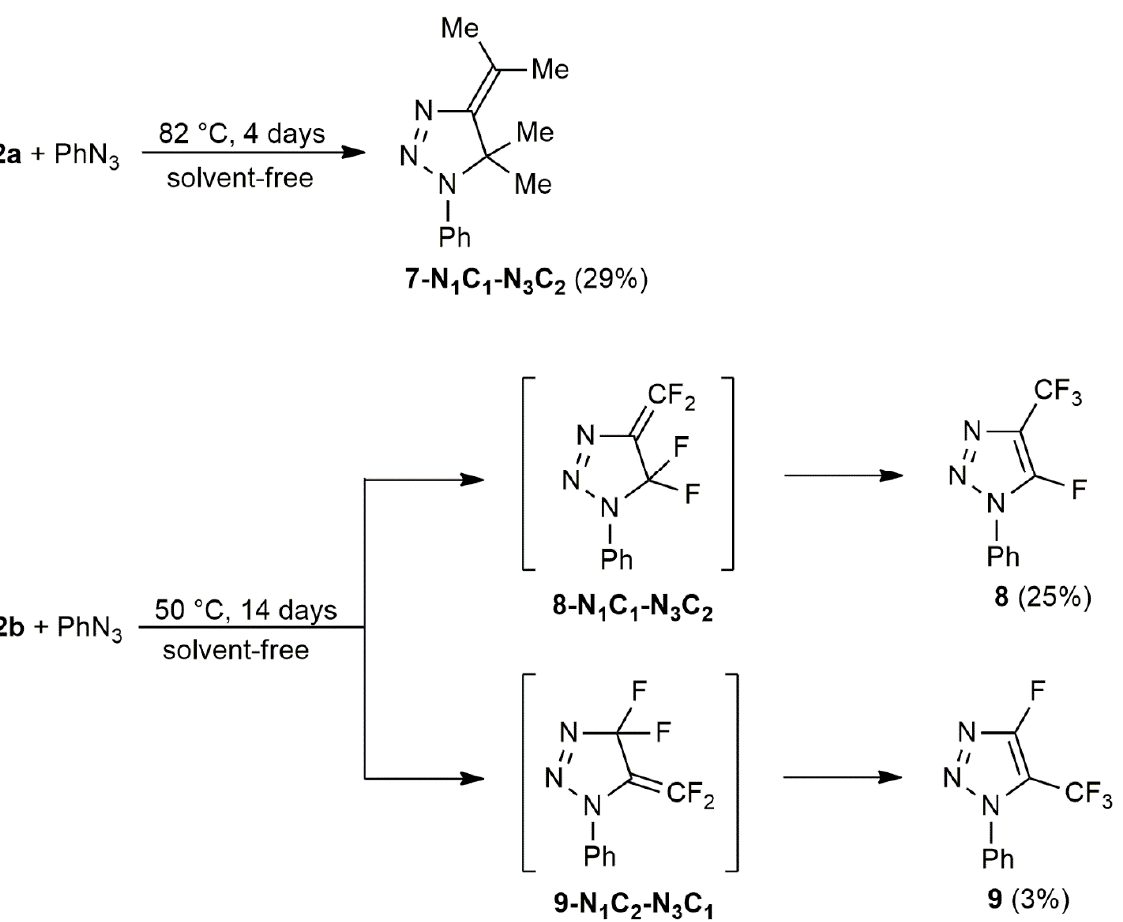
Table 2. Electron chemical potential ( μ ), hardness ( η ), softness ( S ), electrophilicity ( ω ), and nucleophilicity ( N ) of the in- vestigated allenes and azides. All quantities are in given in